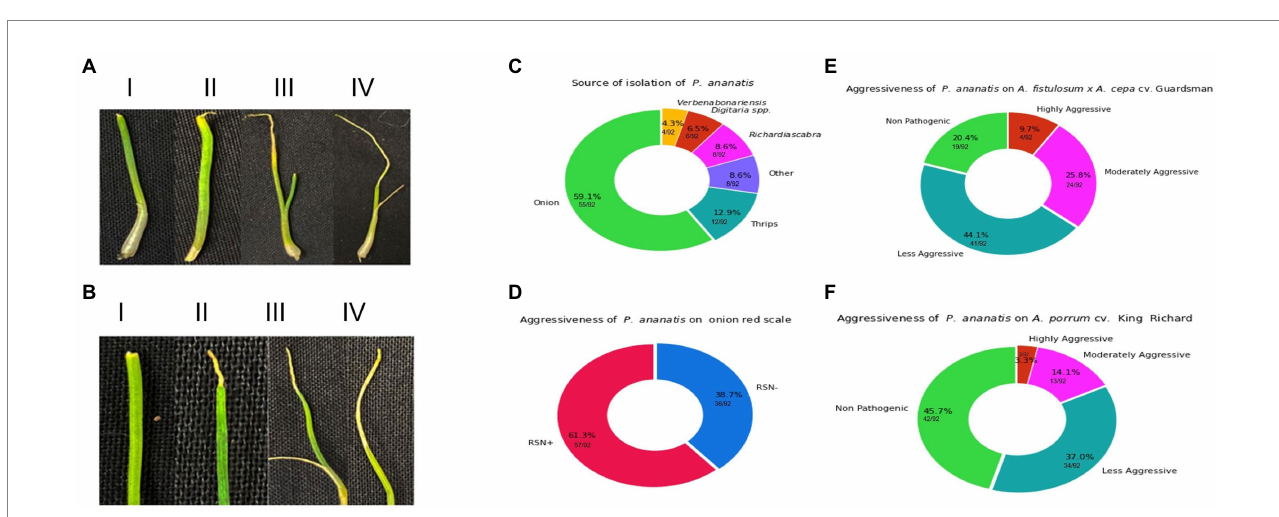
FIGURE 1 Visual representation of spectrum of foliar symptoms caused by Pantoea ananatis inoculation on Allium porrum (cv. King Richard) and Allium fistulosum × Allium cepa (cv. Guardsman) as well as source of isolation and results the red-onion scale necrosis (RSN) assay. (A) Shows examples of foliar lesion severity and strain aggressiveness on A. fistulosum × A. cepa . The panels in A (i–iv) indicate symptoms associated with increasing level of aggressiveness. (B) Shows examples of foliar lesion severity and strain aggressiveness on A. porrum . The panels in B (i–iv) indicate symptoms associated with increasing level of aggressiveness. (C) shows the distribution of the sources of isolation of strains, where A. cepa (onions) contributes majority of the strains (59.1%) and strains from non-onion sources comprise of 40.9% ( Richardia scabra : 8.6%, Digitaria spp.: 6.5%, Verbena bonariensis : 4.3%, thrips: 12.9%, and other sources: 8.6%). (D) Displays the percentage of strains that can cause red-onion scale necrosis (61.3%) and those that could not (38.7%). (E) ( A. fistulosum × A. cepa ) and (F) ( A. porrum ) visualize the breakdown of strains that are either highly- or moderately- or less-aggressive or non-pathogenic on both Allium